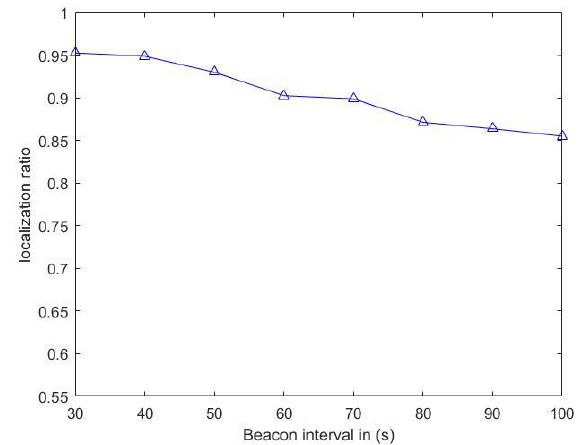
Figure 13. The localization ratio versus beacon interval.